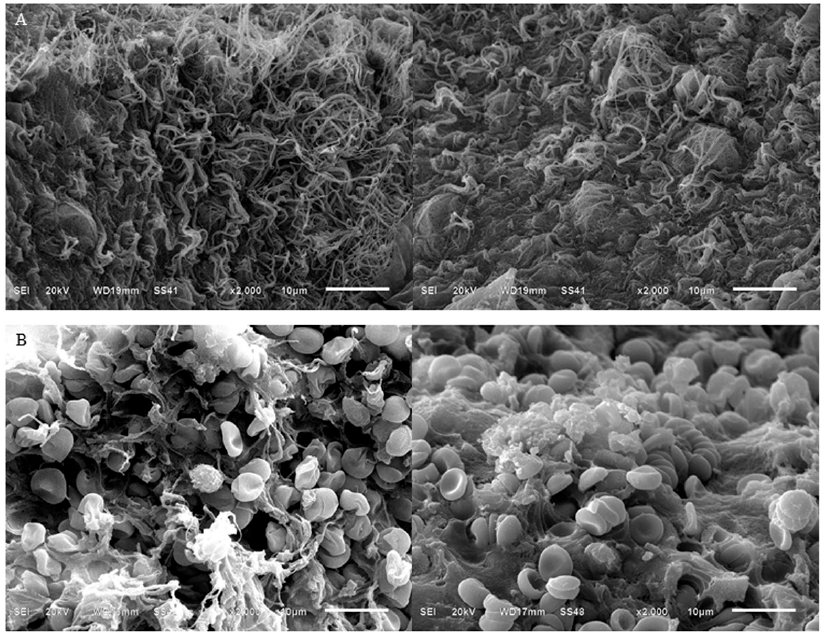
Figure 2. Scanning electron microscope images of i-PRF using different fraction methods. A different position of the harvesting needle led to two types of i-PRF: The yellow and red i-PRF. ( A ) The yellow i-PRF showed a dense and highly organized fibrin network. ( B ) On the other hand, the red i-PRF demonstrated more cellular components of leukocyte, platelets, and erythrocytes than the yellow